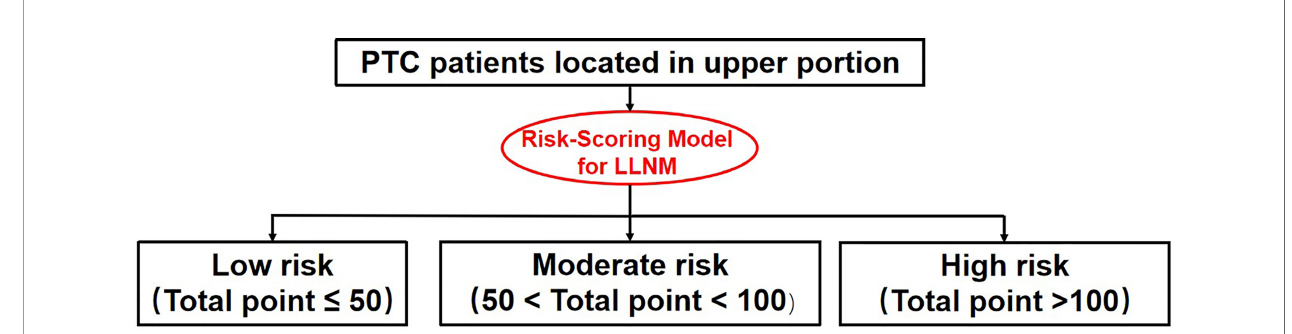
FIGURE 4 | Risk strati fi cation fl ow chart for PTC patients with tumor located in upper